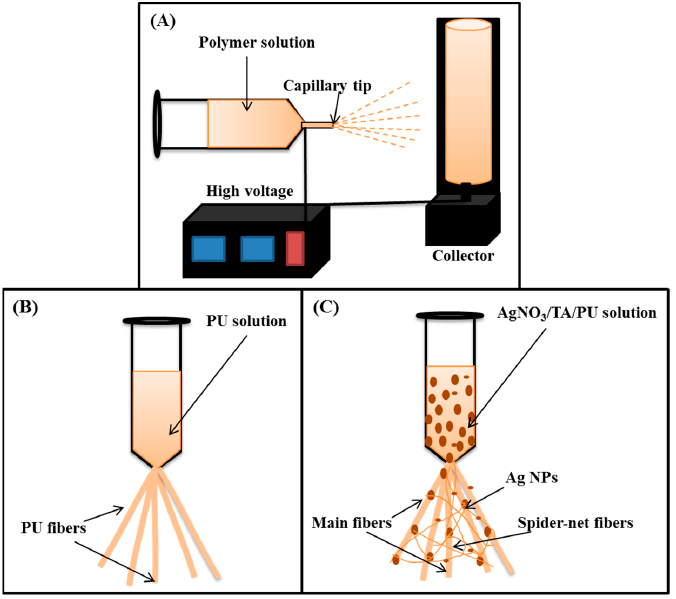
Figure 2. Schematic diagram showing the electrospinning set-up ( A ), mechanism of the formation of PU NFs ( B ), and the spider-net like formation of the Ag/PU NFs ( C ) during electrospinning.